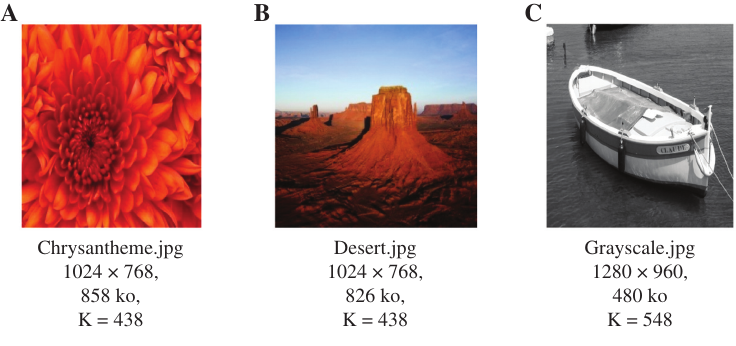
Figure 5: Original Images. (A) Chrysantheme, (B) desert, and (C) grayscale.